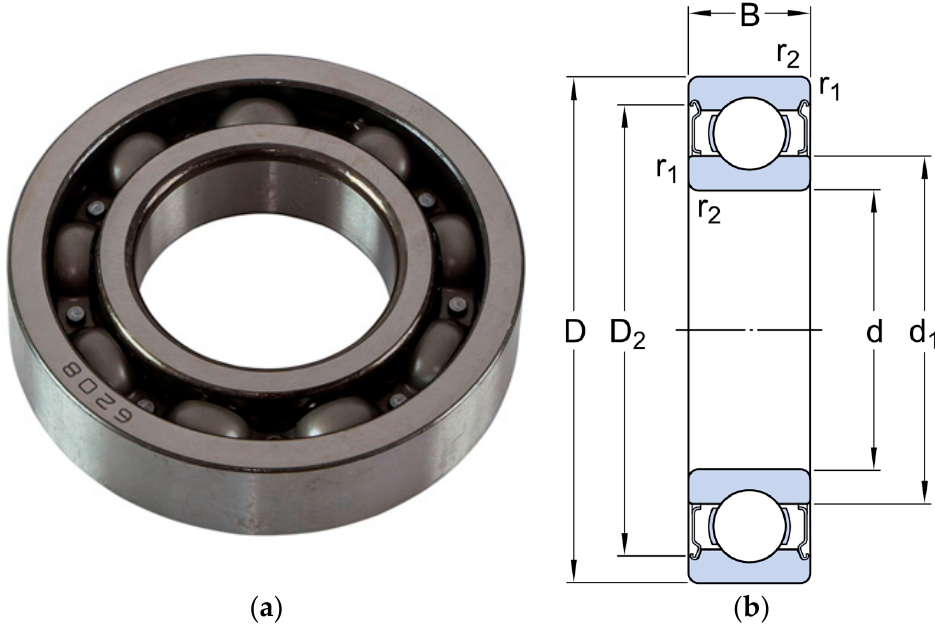
Figure 4. Ball bearings of series—6208: ( a )—general view; ( b )—sketch of product size.